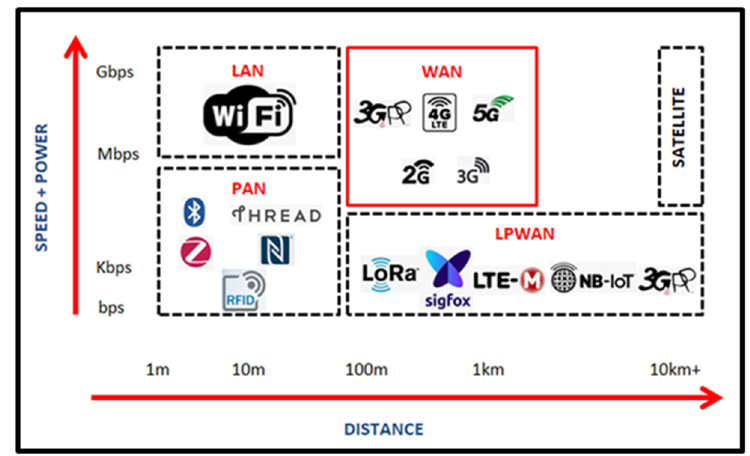
Figure 3. Comparison of IoT technologies .